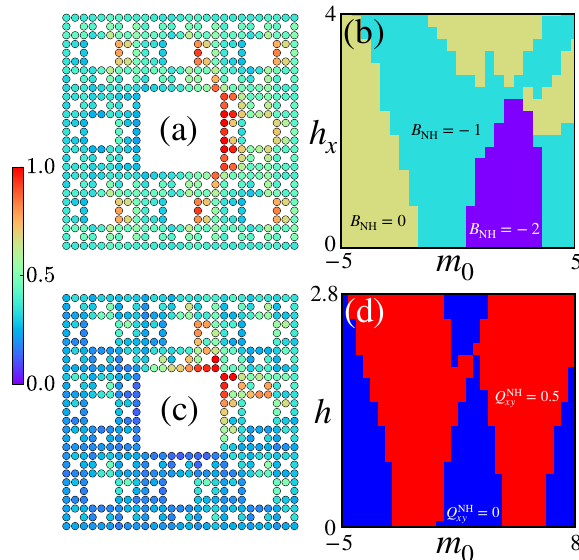
Fig. 5 Mojorana inner skin effects (ISEs) and associated global phase diagrams. a First-order Majorana ISE for the left eigenvectors of H pair FO [Eq. (6)] when m 0 = 0.0, Δ FO = 0.25 and h = (0.5, 0, 0). b Global phase diagram of H pair on the ( m 0 , h x ) plane for Δ FO = 1.0, constructed from the FO non-Hermitian (NH) Bott index B NH . c Second-order Majorana ISE for the left eigenvectors of H pair [Eq. (7)] when m 0 = 3.0, g = 0.5, Δ SO = 0.025 SO and h = ( − 0.53, − 0.53, 0). d Global phase diagram of H pair on the ( m 0 , h ) SO plane, constructed by computing the NH quadrupole moment Q NH for xy neutral Majorana fermions for g = 0.5 and Δ SO = 1.25. Throughout we set t = t 0 = 1, R = 8 a and r 0 = a . Right eigenvectors of H pair ( H pair ) show inner FO SO fi rst-order (second-order) skin effects, but around opposite edges (diagonally opposite corners), as shown in Supplementary Fig.